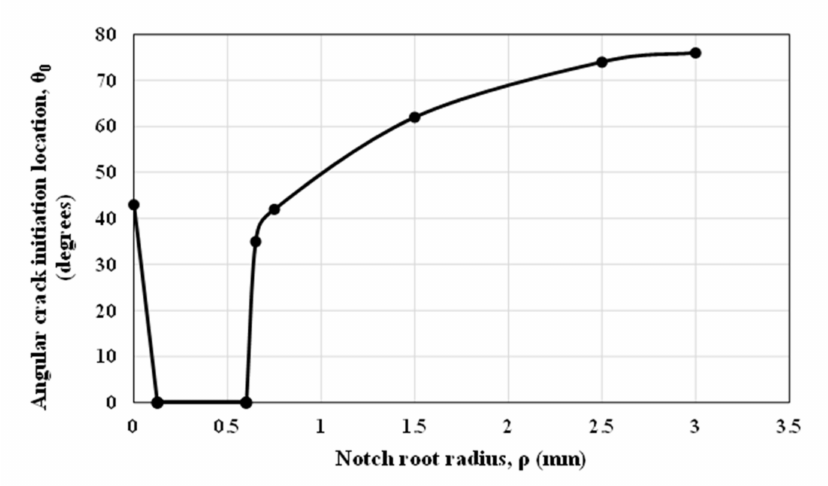
Figure 13. Crack initiation angle variations obtained from numerical analyses for different notch root radii in DCB 1 blunt V-notched specimens ( γ = 15 ◦ ).